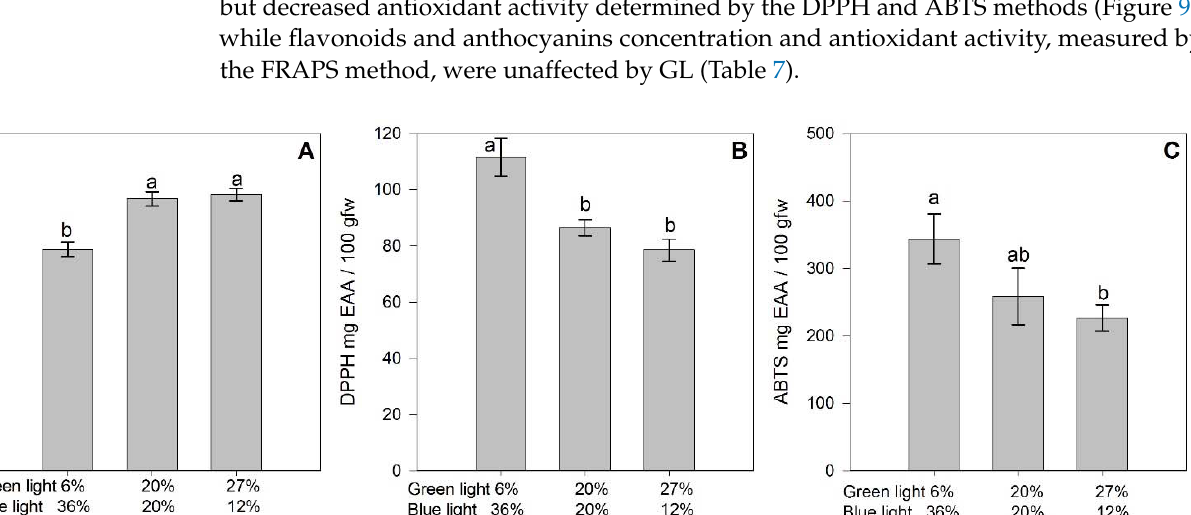
Figure 8. Effect of the green (500–600 nm) and blue (400–500 nm) light balance on calcium from fruit extracts of strawberry grown in an indoor vertical system with LED lighting. Bars represent the standard error of the mean. Columns with different letters indicate significant differences according to Duncan’s multiple comparison test with p < 0.05.